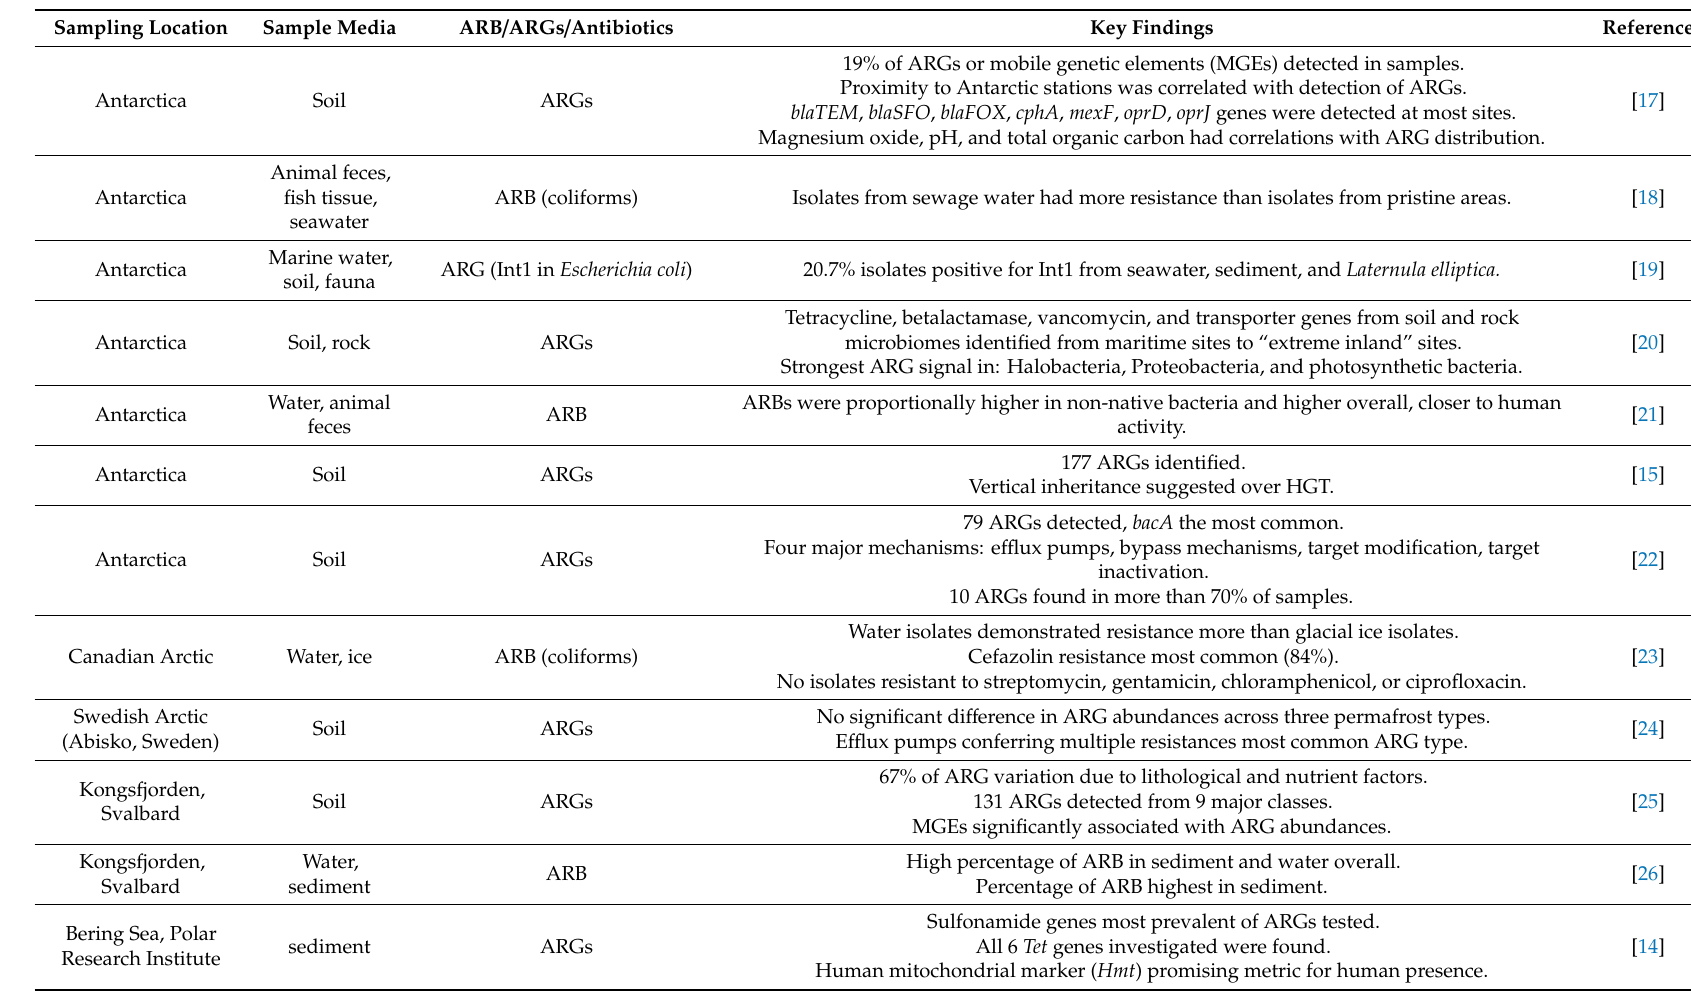
Table 1. Summary of studies investigating the presence of antibiotic resistant bacteria (ARB) and antibiotic resistance genes (ARGs) in minimally human-impacted